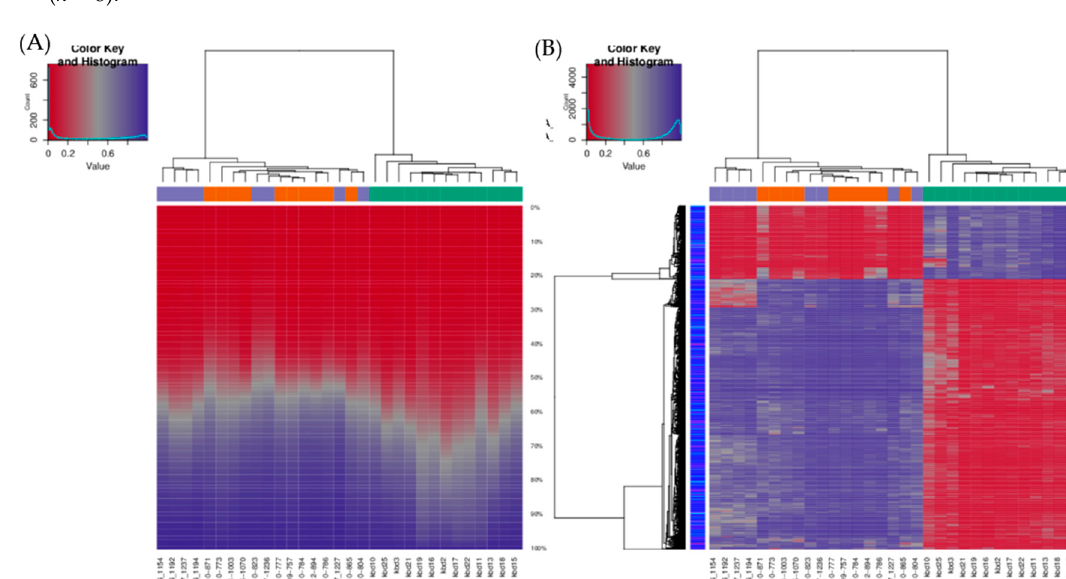
Figure 2. Infinium MethylationEPIC BeadChip findings: Hierarchical clustering of samples based on all methylation values. ( A ) The heatmap displays methylation percentiles per sample. ( B ) The heatmap displays only selected sites / regions with the highest variance across all samples. Green: HNSCC samples, oropharyngeal cancer ( n = 6) and oral cancer ( n = 7), orange: Oral lesions, OLP ( n = 8) and OLL ( n = 2), violet: Healthy oral mucosa ( n = 8).